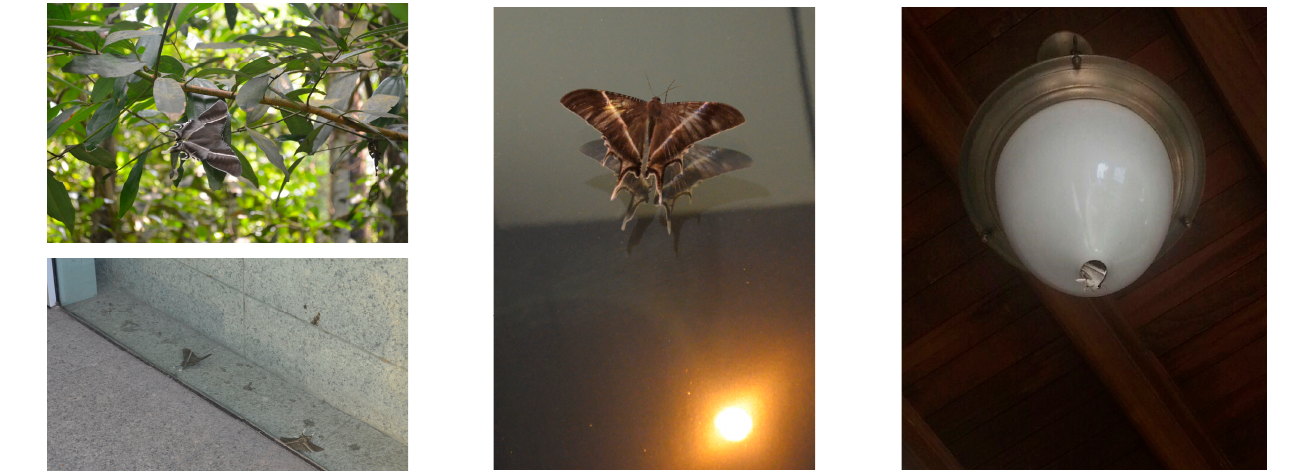
Figure 2. Lyssa zampa moths in forested and urban areas photographed during the mass emergence in 2014 across Singapore (photos by Anuj Jain). Several individual moths were seen attracted to city lights and eventually trapped in glass panels or light bulbs.